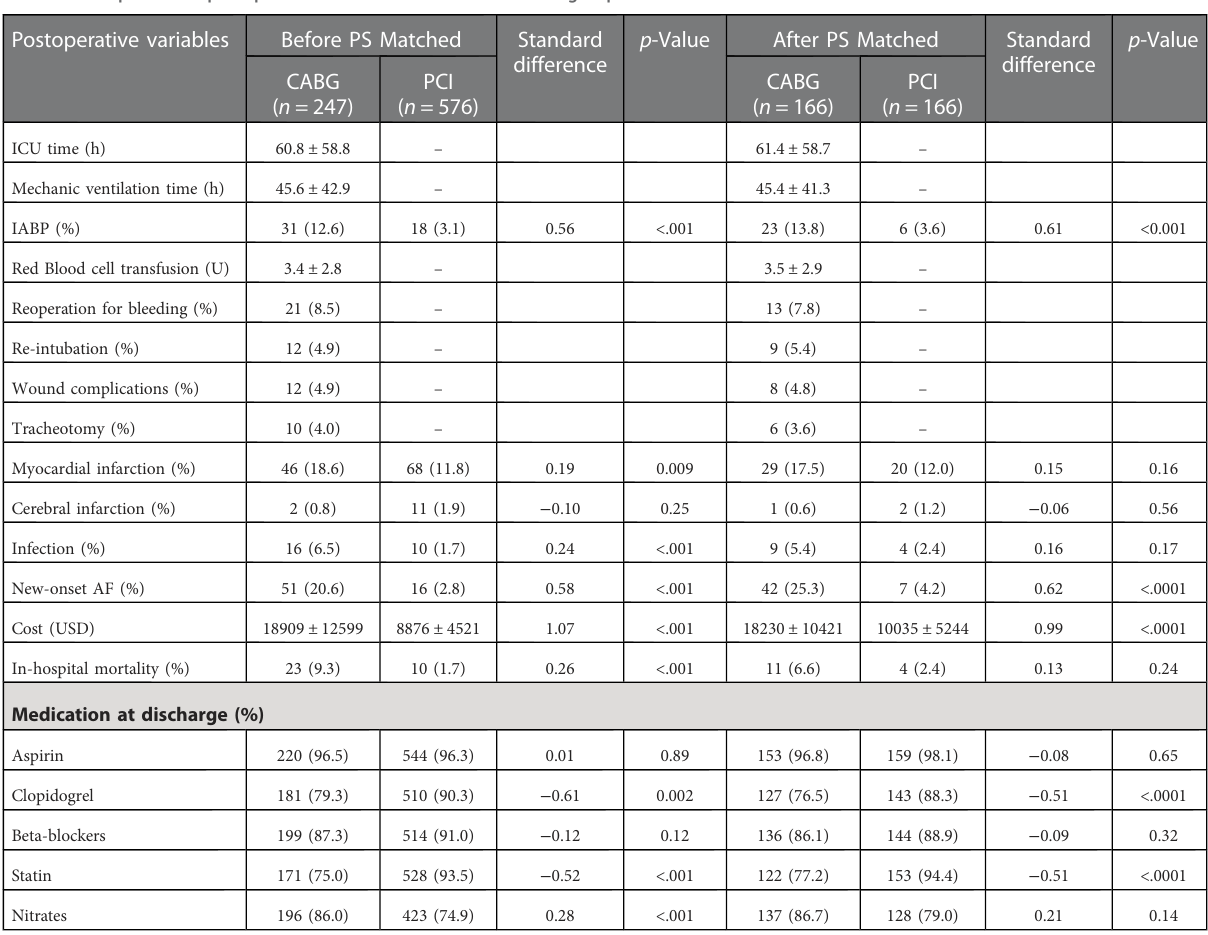
TABLE 3 Comparison of postoperative data between CABG and PCI